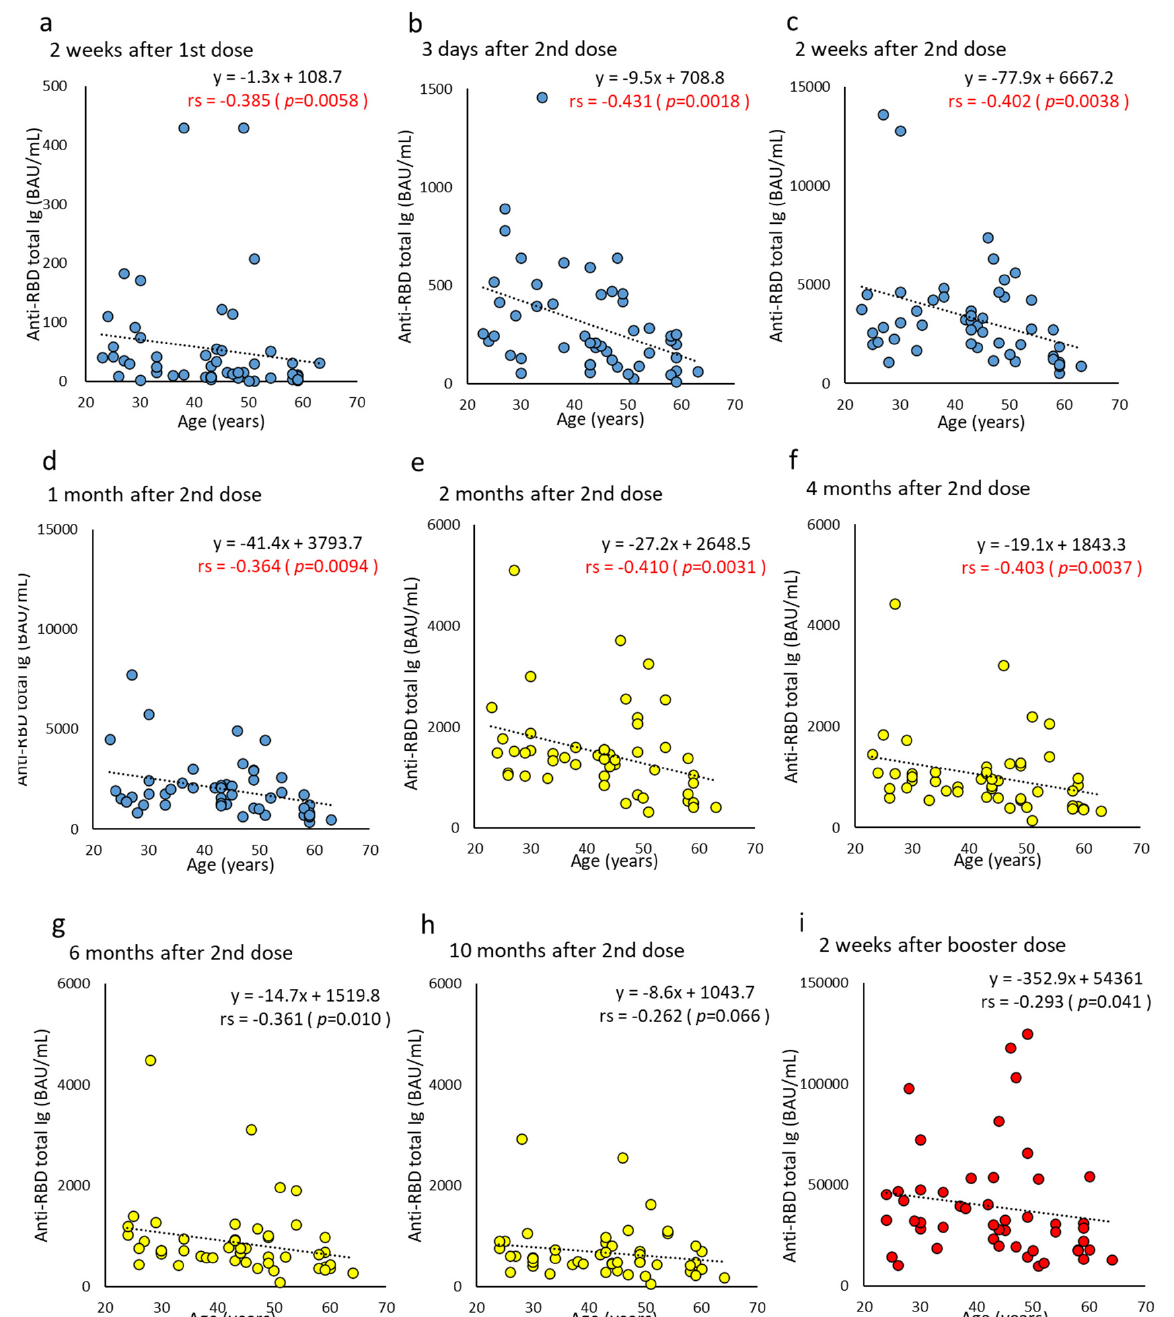
Figure 2. ( a – i ). Correlation at time points between age and anti-RBD total Ig after BNT162b2 vaccine doses. Parameter levels indicating anti-RBD total Ig of humoral immunity against SARS-CoV-2 are plotted and compared according to age at each time point post-vaccine doses. Time points until one month after two doses are colored blue ( a – d ), from two months to 10 months after two doses are colored yellow ( e – h ), and two weeks after the booster dose are colored red ( i ). p -values were calculated using Spearman’s rank correlation test and significance was set at 0.01. Red values indicate a significant correlation (rs, Spearman’s rank correlation